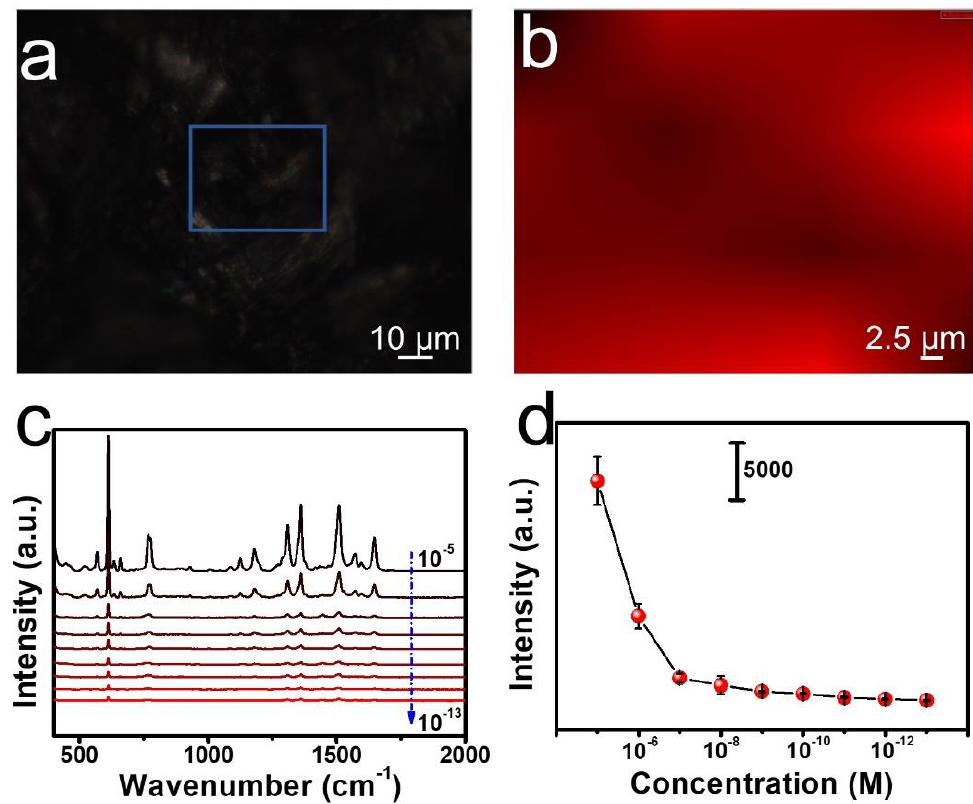
Figure 4. SERS measurements of R6G molecules. ( a ) Optical microscopy image of paper-based SERS substrates. ( b ) Raman mapping image at 613 cm − 1 with 633 nm laser excitation. ( c ) SERS spectra of different concentration (10 − 5 M to 10 − 13 M) of R6G molecules on substrates under the irradiation of 633 nm laser. ( d ) Plot of SERS intensityfor the paper- based SERS substrates has been developed via the controllable face-to-face assembly of Ag nanoplates on filter paper. Our theoretical simulations showed that a high density of hotspots was distributed nearby the assembled nanostructures. Therefore, the paper-based SERS substrates showed efficient and homogeneous distribution of SERS spectra dyes and pesticide. The developed paper-based SERS substrates can be potentially applied in the food safety, environment monitoring, and defense security